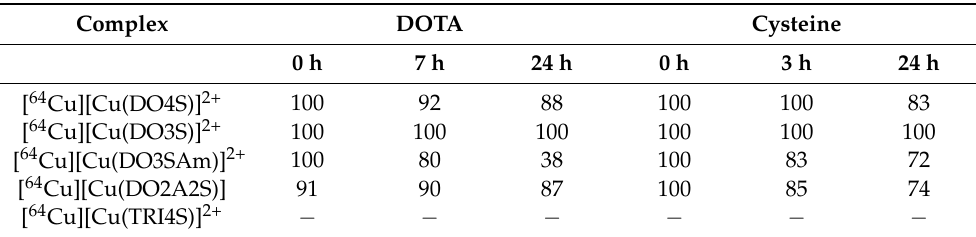
Table 2. Time-dependent stability of [ 64 Cu]Cu 2+ complexes in the presence of DOTA (1000: 1 DOTA- to-ligand molar ratio) and cysteine (1000:1 Cys-to-ligand molar ratio). Values are represented as % of intact complex. Uncertainties are in the order of ± 2% and are omitted for sake of clarity. Complex